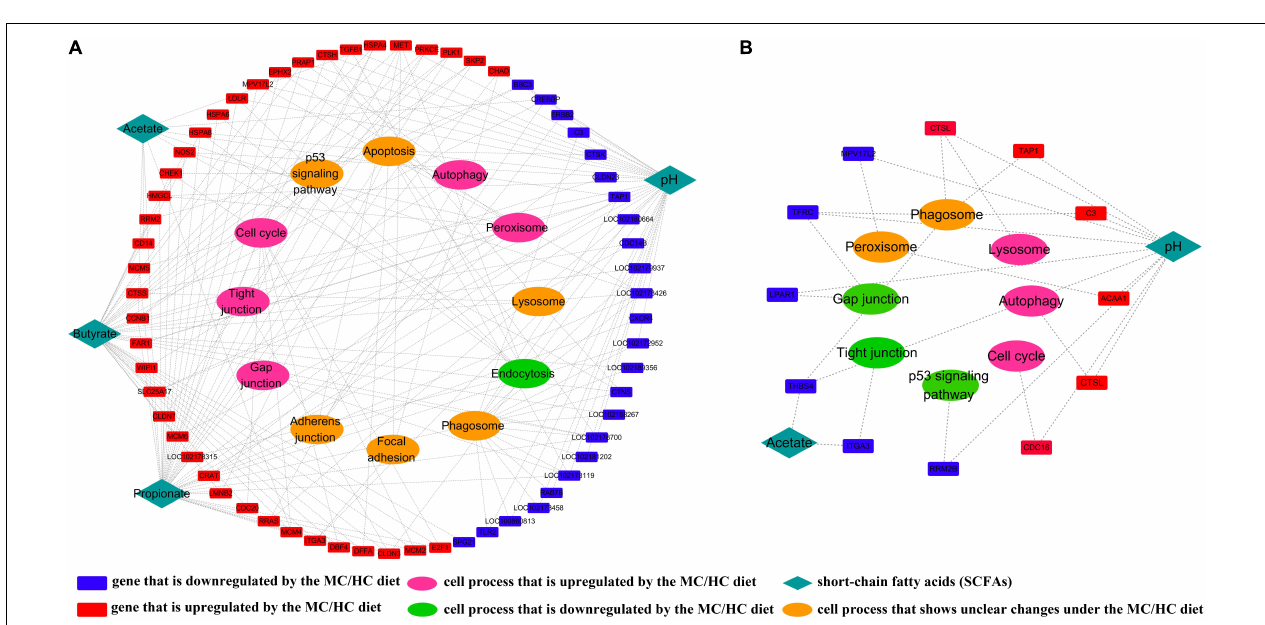
FIGURE 4 | (A) Upregulated/downregulated KEGG pathways related to the immune system and cellular process in the rumen epithelium of the MC group, compared with those in the LC group; (B) upregulated/downregulated KEGG pathways related to the immune system and cellular process in the rumen epithelium of the HC group, compared with those in the MC group.